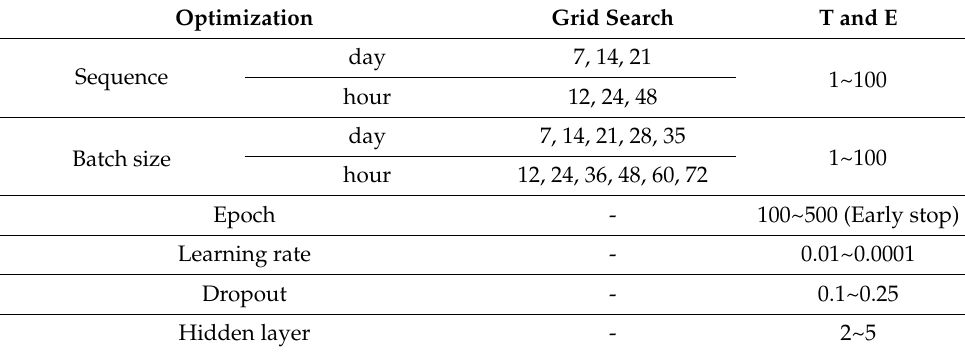
Table 2. Application range for hyperparameter optimization.